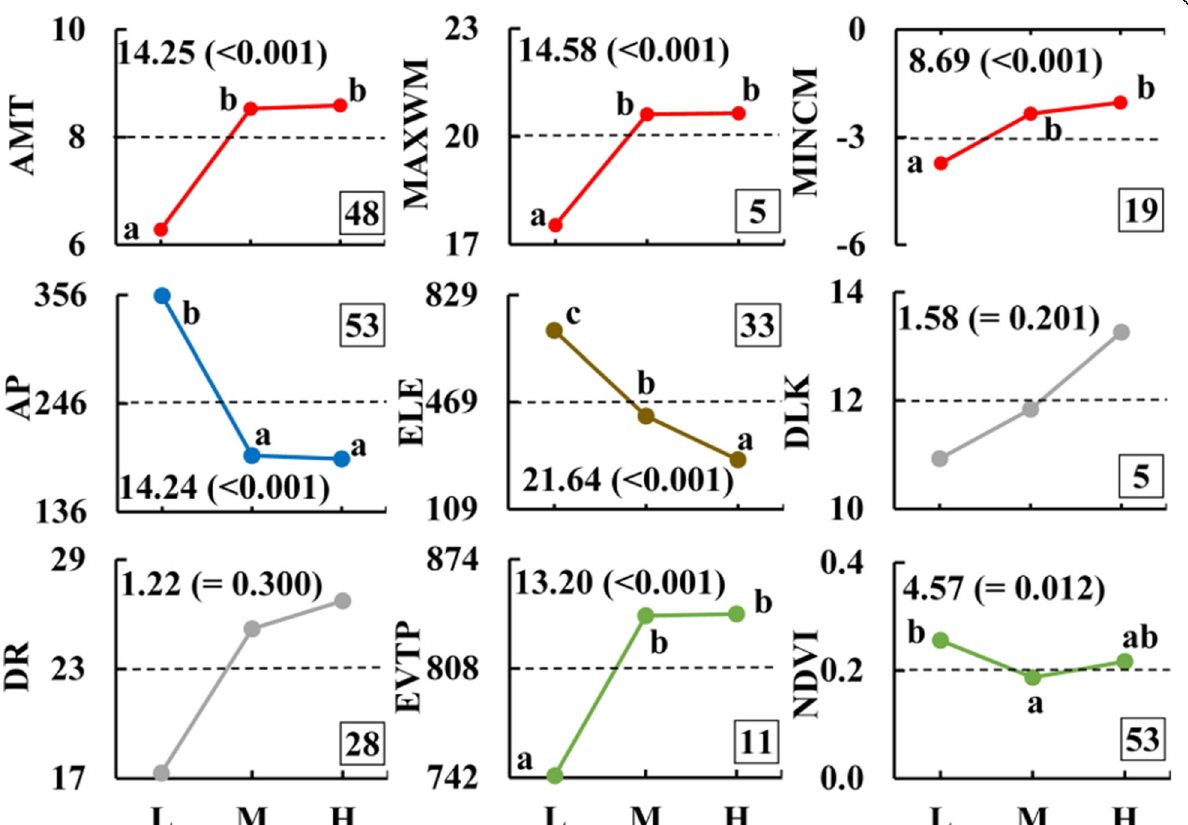
Fig. 5 One-way ANOVAs comparing the potential biodiversity (L < 51, M = 51 – 62, H > 62) for the nine explanatory environmental variables used for habitat modelling of plant species. The dotted line indicates the mean value for Santa Cruz Province. F -value and probability (between brackets) are presented for each analysis, where different letters showed significant differences among categories of potential biodiversity using the Tukey test at p < 0.05. The numbers in the boxes indicate how many times the variable was used for modelling each plant species. AMT, annual mean temperature (°C); MAXWM, max temperature of the warmest month (°C); MINCM, min temperature of the coldest month (°C); AP, annual precipitation (mm year − 1 ). In brown colour: ELE, elevation (m.a.s.l.); DLK, distance to lakes (km); DR, distance to rivers (km); EVTP,